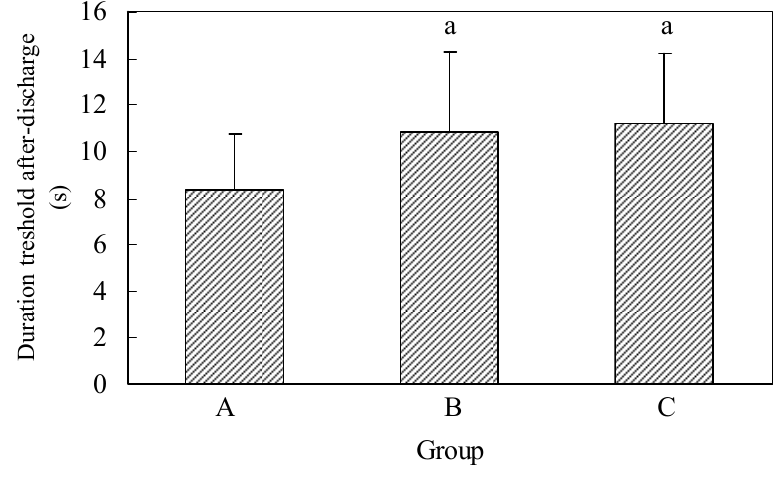
Figure 2. Duration of threshold